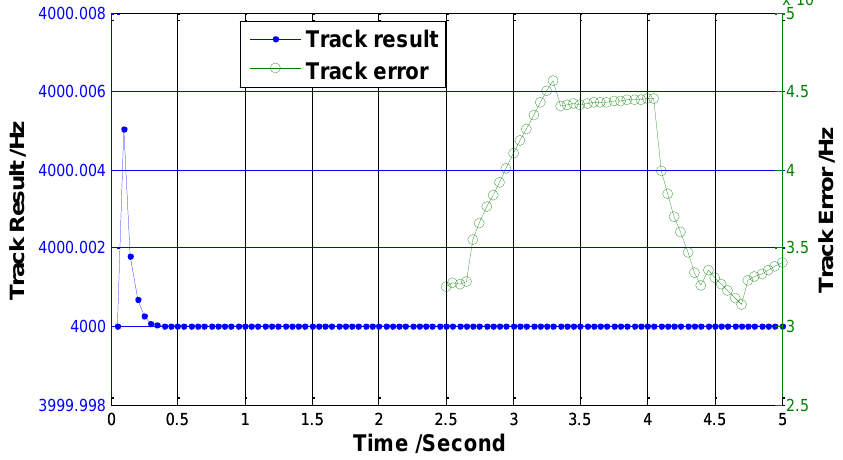
Figure 10. Measurement value (left) and error (right) for a constant resonant frequency ( f = 4,000 Hz) using the track method. r